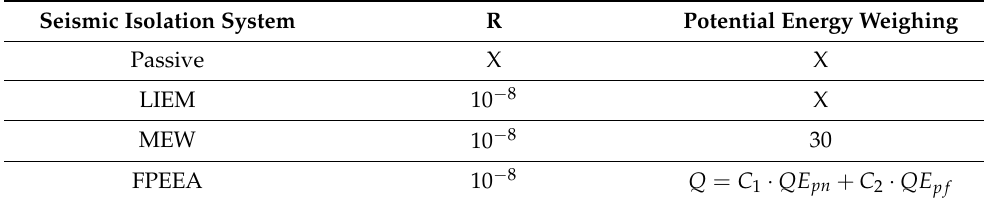
Figure 3. Comparison of different control parameters. ( a ) Superstructure acceleration (Whittier Narrows-01). ( b ) Superstruc- ture acceleration (TCU068-EW). ( c ) Isolation layer displacement (Whittier Narrows-01). ( d ) Isolation layer displacement (TCU068-EW). Table 6. Parameters of each control